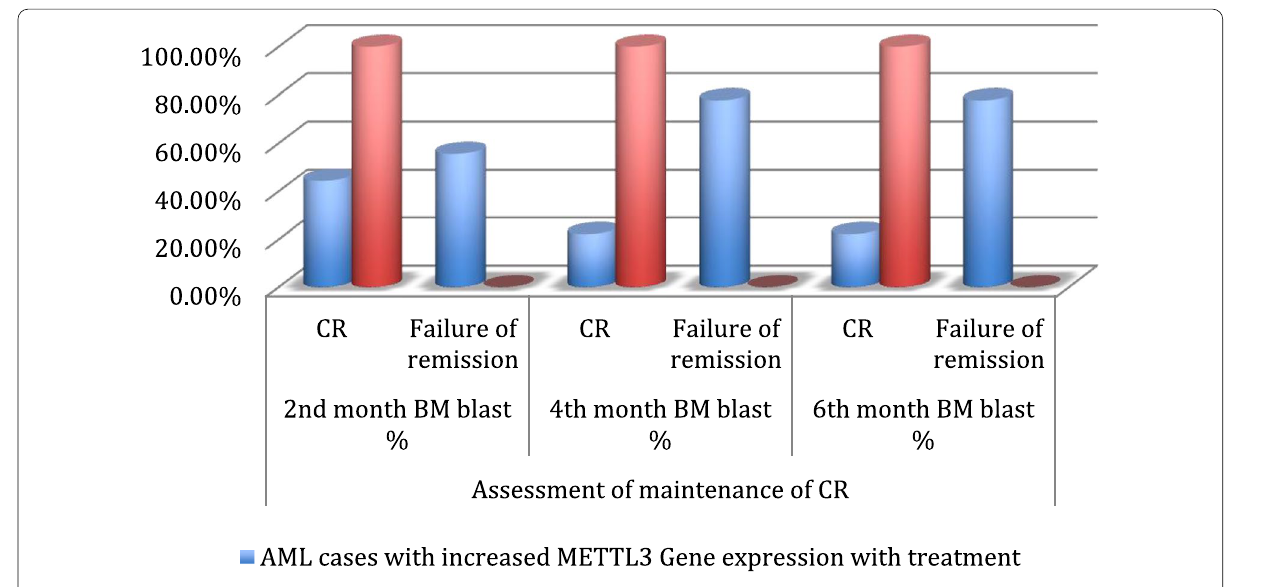
Fig. 4 Bar chart showing the follow‑up response in both AML subgroups with elevated and reduced gene expression level with